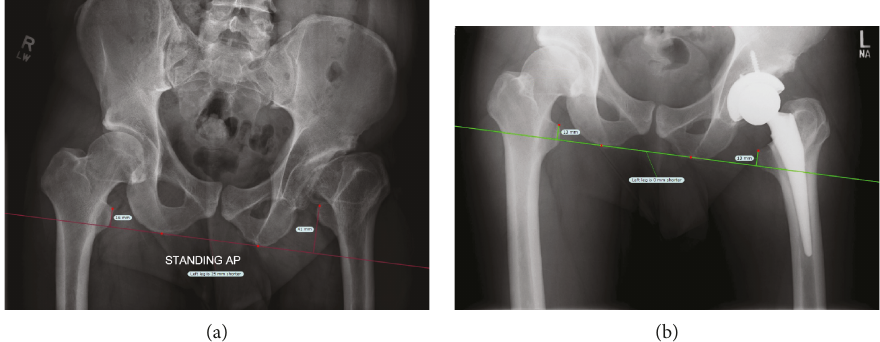
Figure 1: Pre- (a) and postoperative (b) radiographs for Case 1. Preoperatively, the LLD was estimated at 2.5cm. Leg lengths were equalized